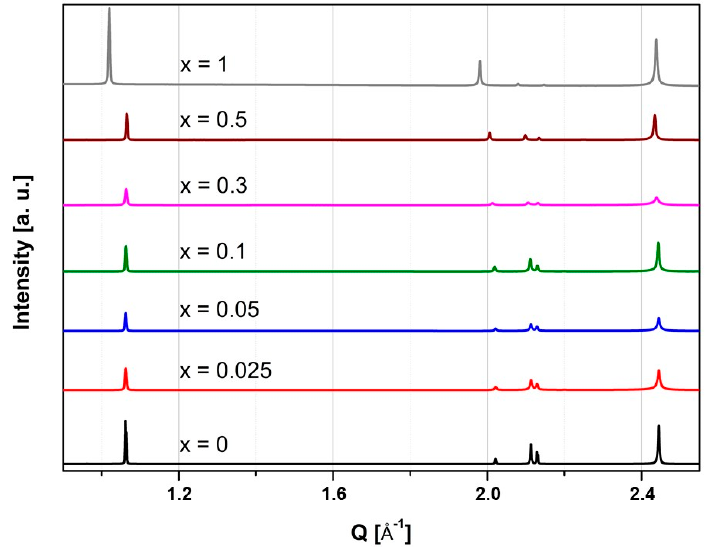
Figure 1. SR-PXD patterns of Mg 1 − x Mn x Cl 2 (x = 0, 0.025, 0.05, 0.1, 0.3, 0.5 and 1) obtained at RT. All peaks belong to the same CdCl 2 -type phase.